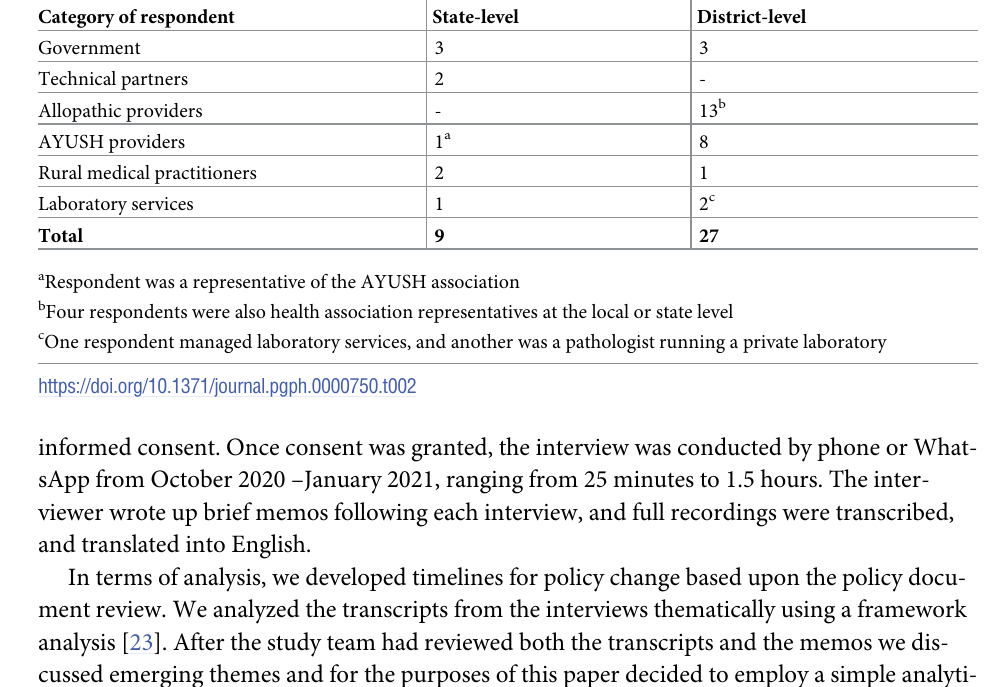
Table 2. Study respondents at the district and state